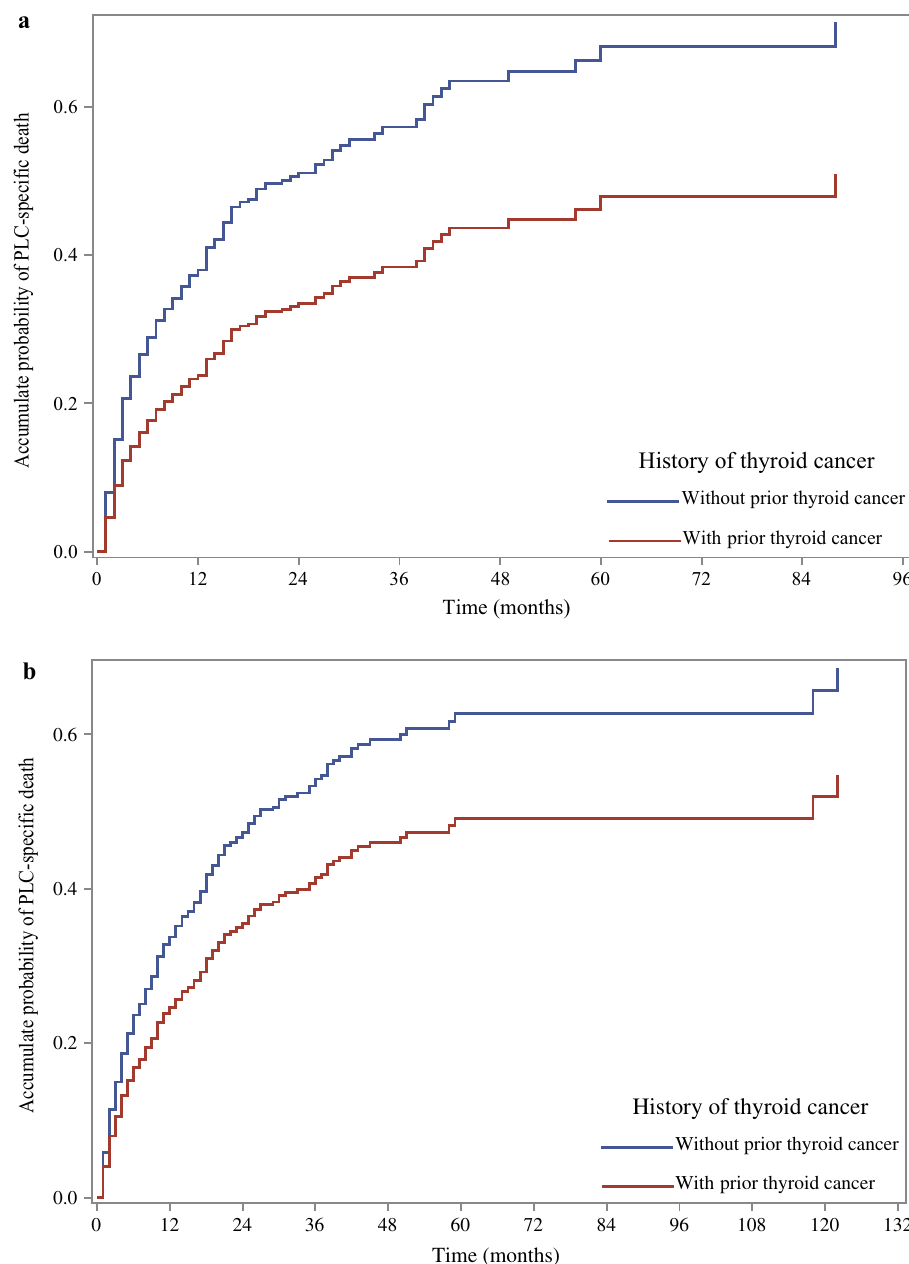
Figure 3. The cumulative incidence of PLC-specific death between PLC patients with and without prior thyroid cancer in female ( a ) and male ( b ). PLC primary liver